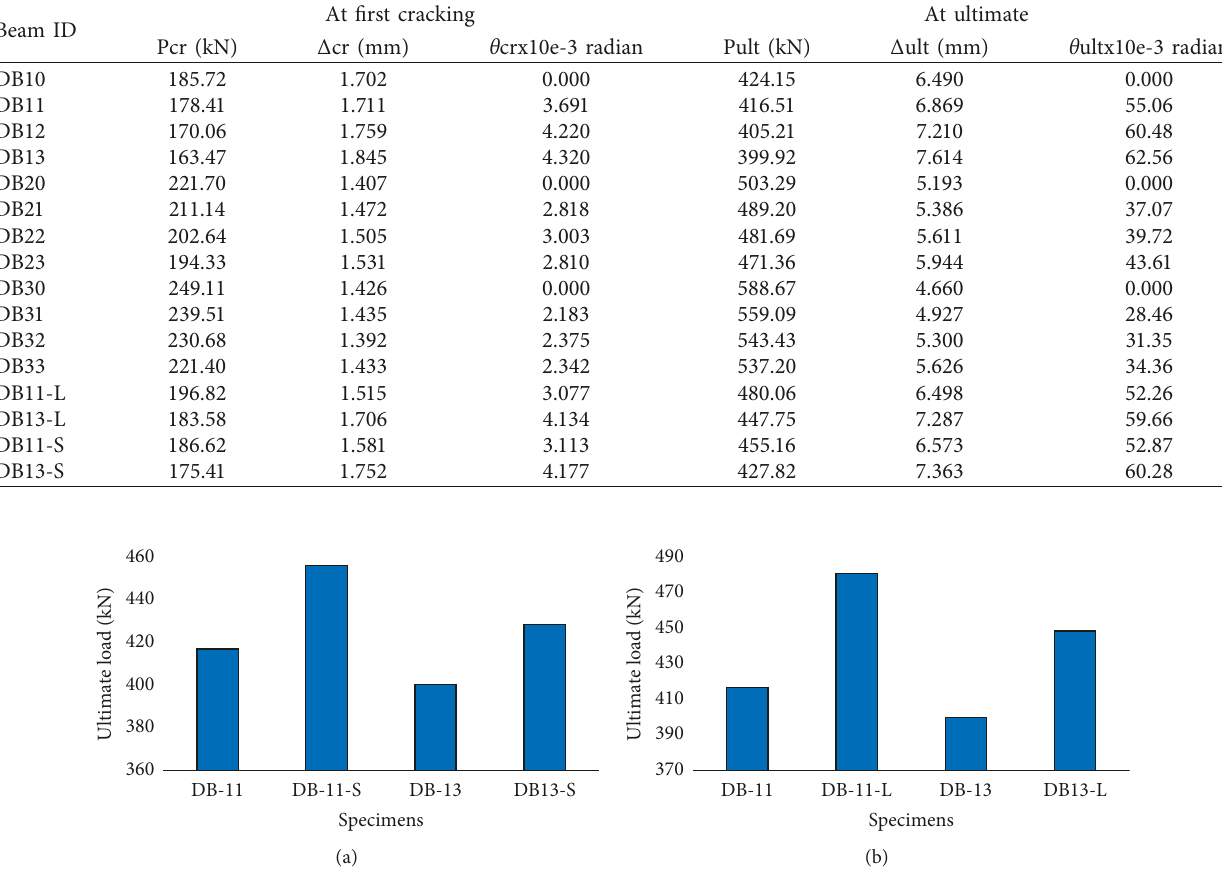
Figure 16: Load-carrying capacity comparison under different L/R ratios. (a) Beam with L/D ratio equal to 3, (b) beam with L/D ratio equal to 2.67, and (c) beam with L/D ratio equal to 2.4. Table 6: Summary of outputs from FE simulation.